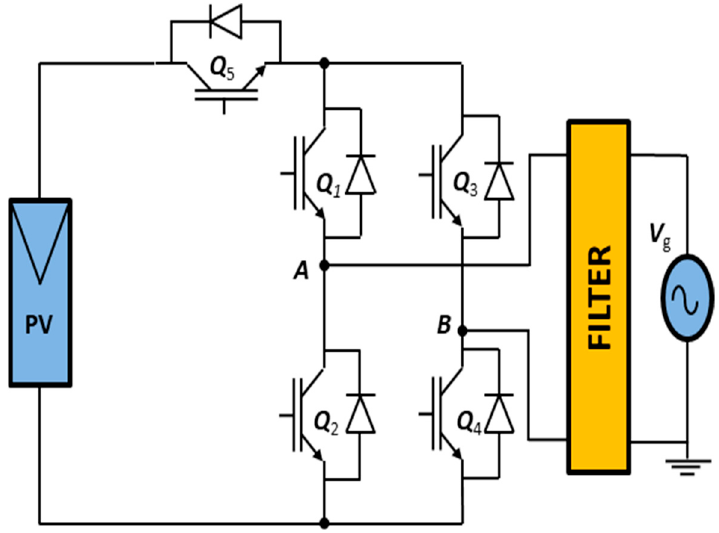
Figure 1. H5 inverter topology.